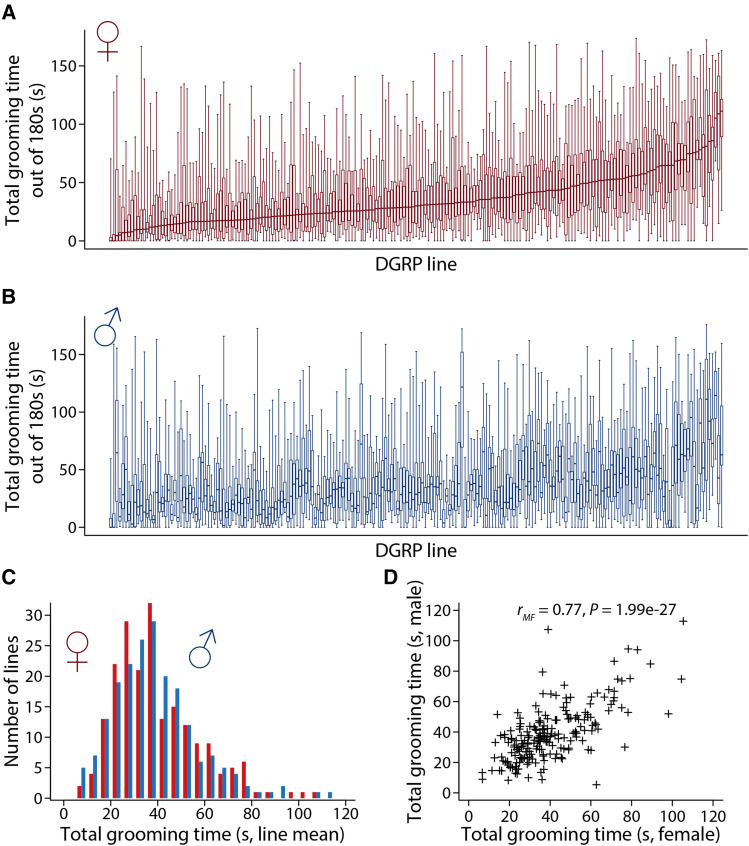
Variation in spontaneous grooming duration (s) in 201 DGRP lines. Flies were observed for 180 s. (a) Total grooming time for females, arranged from lowest to highest grooming time. The box plot for each line indicates the distributional property of the replicates. (b) Total grooming time for males. The lines are in the same order as for females. (c) Distribution of line means for grooming time in the DGRP. Lines are grouped in 5 s bins. The red histograms indicate female line means and the blue histograms indicate male line means. (d) Relationship between male and female grooming time for each line.